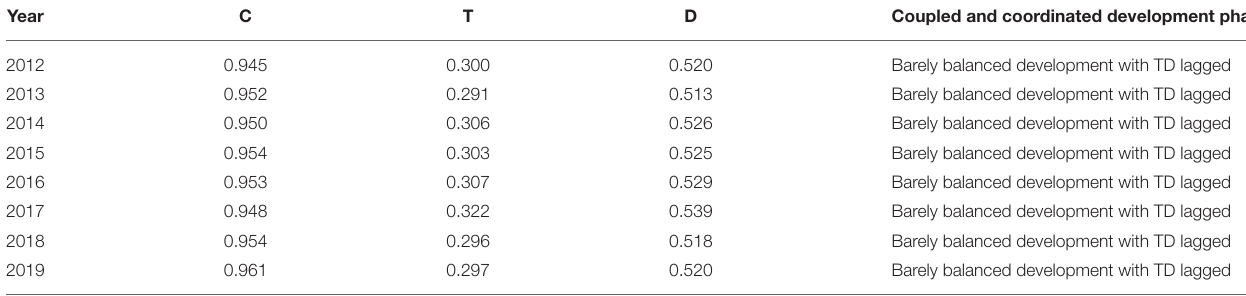
TABLE 3 | Coupling coordination degree and the development stage between tourism development and medical services.